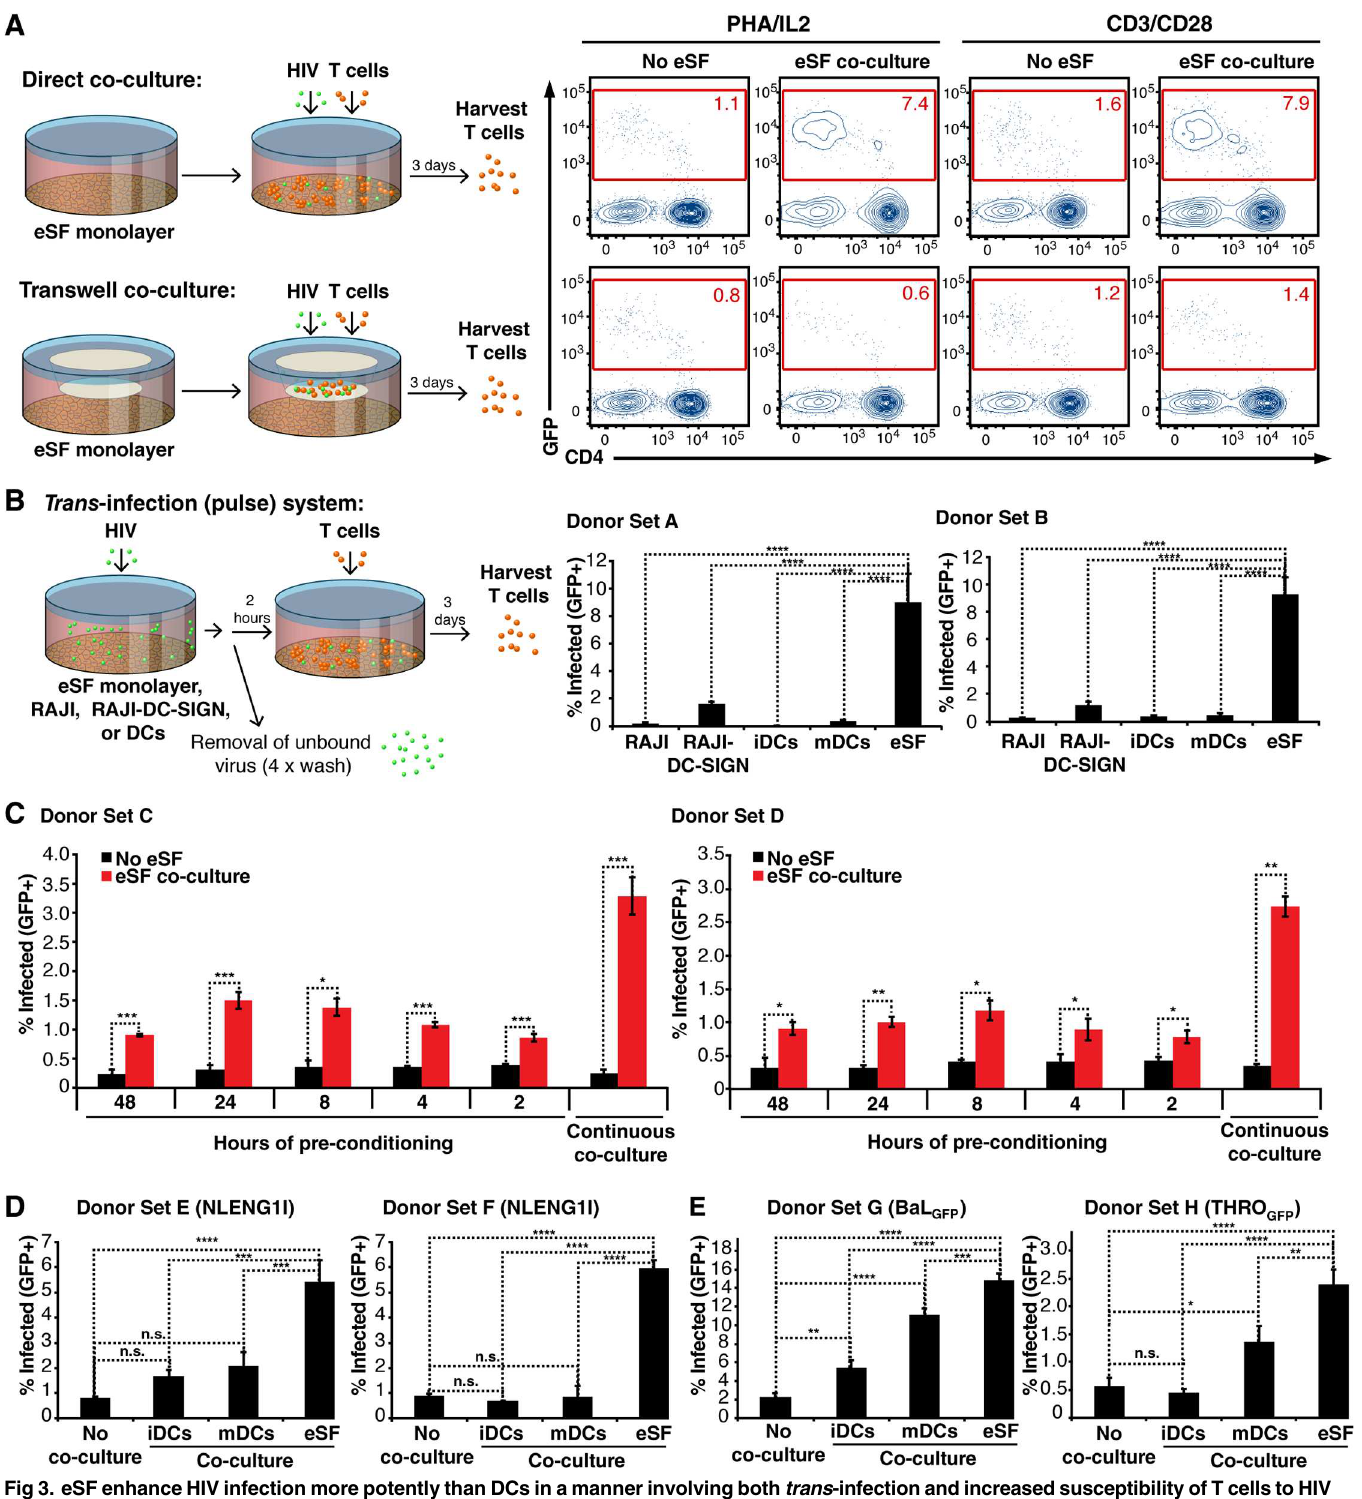
Fig 3. eSF enhance HIV infection more potently than DCs in a manner involving both trans -infection and increasedsusceptibility of T cells to HIV infection. (A) eSF-mediated enhancement of HIV infection requiresdirect contact betweeneSF and CD4+ T cells. PHA/IL2-activated PBMCs and eSF culturedtogetheror separated by a transwellwere infectedwith NLENG1I and monitored 3 d later for infectionlevels. The schematic on the left illustrates the regularco-culturesystem wherecells are in direct contact, comparedto the transwellsystem wherePBMCs are physicallyseparatedfrom eSF. Plots in the top row correspondto direct co-culture conditions,plots in the bottom row correspond to transwell co-cultureconditions.Results are gated on live, singlet CD3